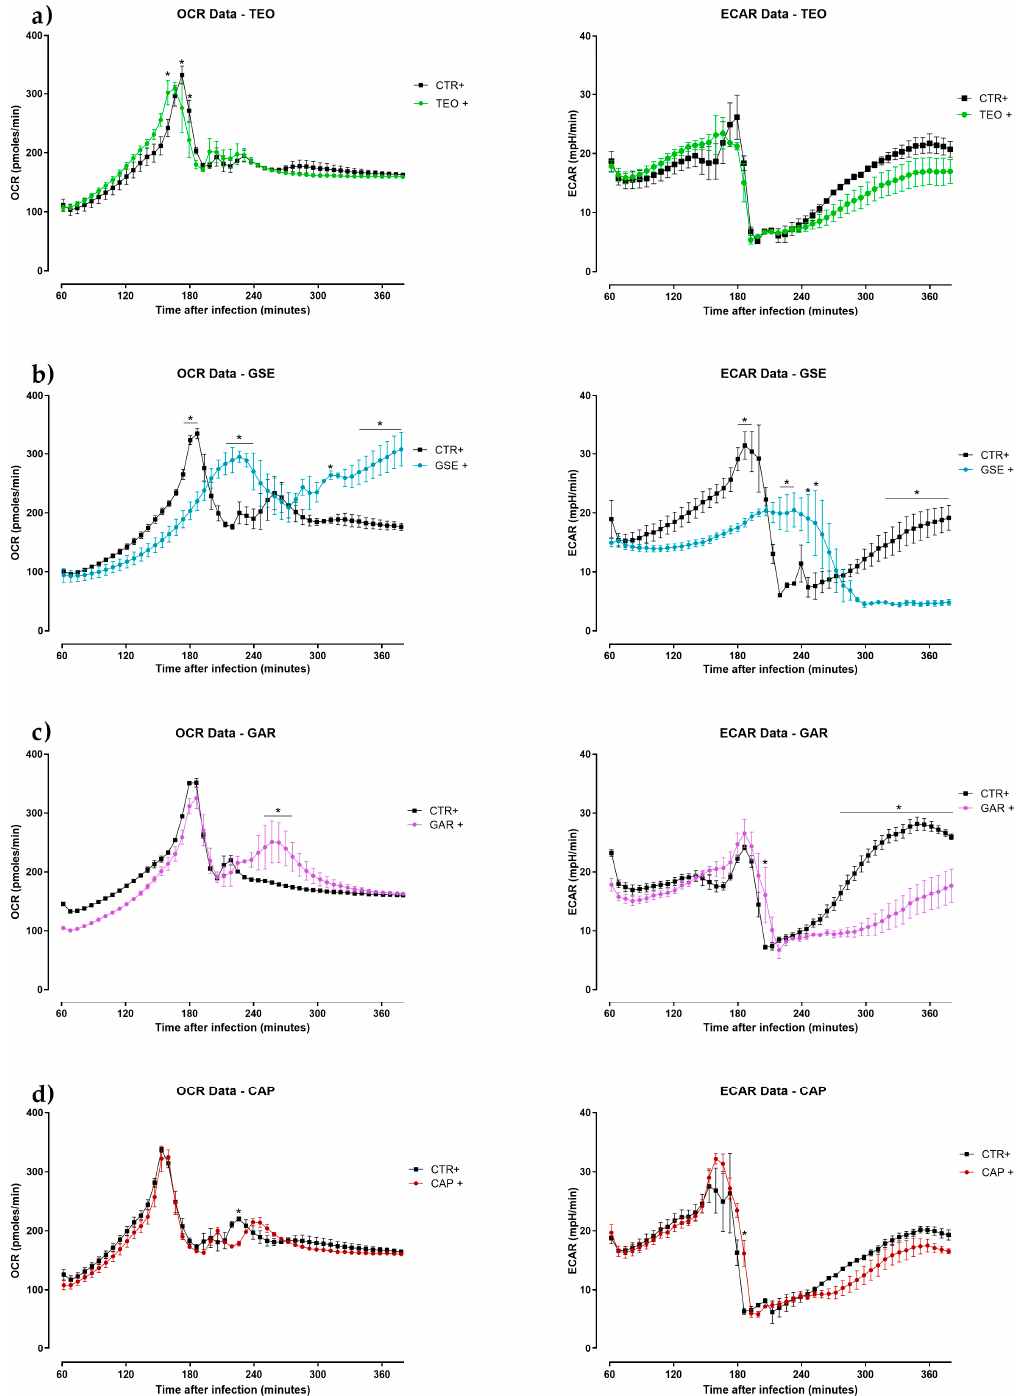
Figure 5. Oxygen consumption rate (OCR) and extracellular acidification rate (ECAR) of HD11 cells infected with Salmonella Enteritidis and treated with plant extracts (( a )—thyme essential oil (TEO), ( b )—grape seed extract (GSE), ( c )—garlic oil (GAR), or ( d )—capsicum oleoresin (CAP)) for 6 h. The reads start from 60 min since, during the first hour, the Seahorse XFp Analyzer requires an internal calibration. Data are expressed as the mean ± SEM ( n = 3). Asterisks * indicate statistical significance with p ≤ 0.05.